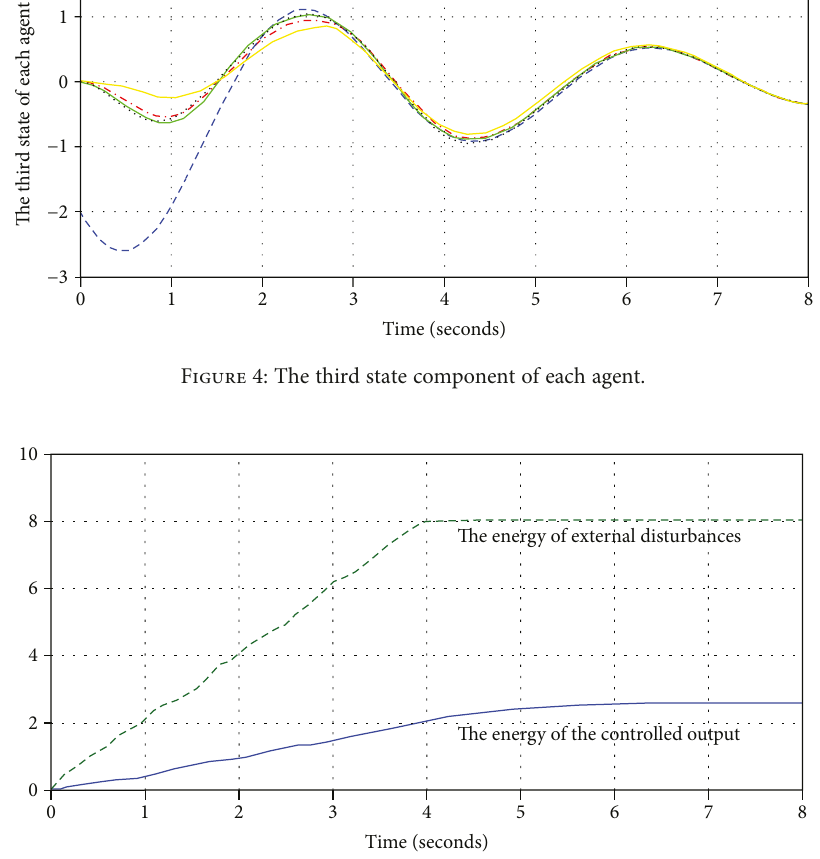
Figure 5: The energy of external disturbances and the controlled output.